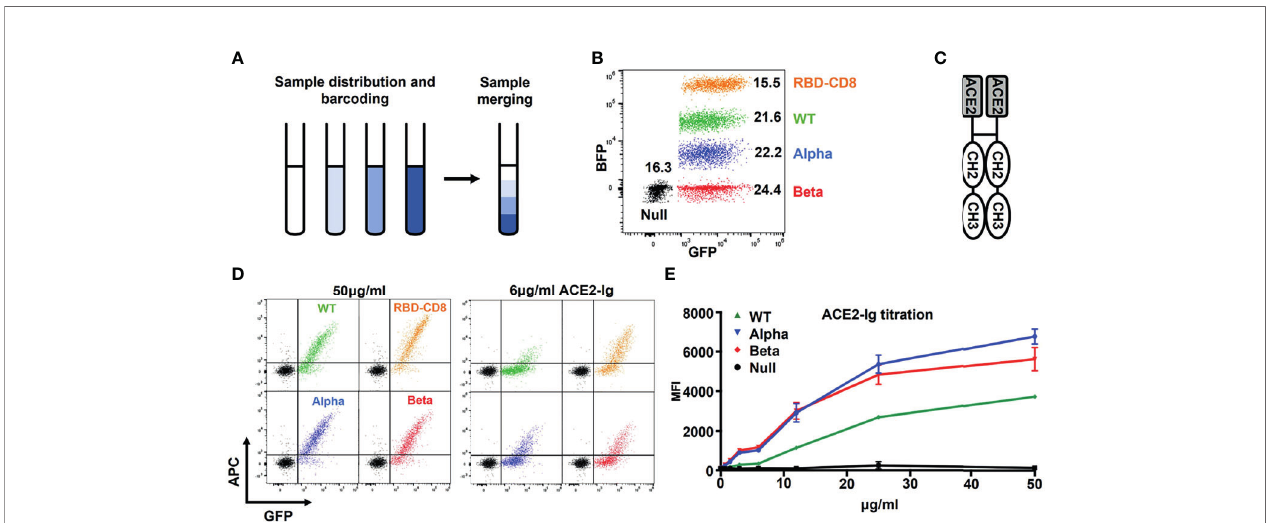
FIGURE 2 | Establishment of the color-based barcoded spike fl ow assay (BSFA). (A) Labeling of four different Ramos cell populations by exposure to different concentrations (0, 1:250, 1:1250, 1:10.000) of CytoTell blue for further analysis in one test tube. (B) Gating strategy for the analysis of four different Ramos cell populations by fl ow cytometry. The CytoTell blue -loaded Ramos cells are separated by the blue fl uorescent protein (BFP) gate. (C) Structural model of the chimeric ACE2-Ig molecule used for the detection of the S protein or the RBD-CD8 chimera on transfected Ramos cells. (D) Analysis of Ramos cells expressing the WT (green), alpha variant (blue), beta variant (red) S protein or the RBD-CD8 construct (orange). The cells were exposed to either 50 or 6 ug/ml of ACE2-Ig, washed, stained with APC-coupled anti-human IgG antibodies and then analyzed by fl ow cytometry. Shown is the dot plot depicting the GFP and APC fl uorescence form each one of the variants overlay with the Ramos-Null (GFP-) control cell line. (E) Titration of the ACE2-Ig binding to the four indicated Ramos cell populations. As negative control we used Ramos cells without S protein (black). The mean values of three different experiments are